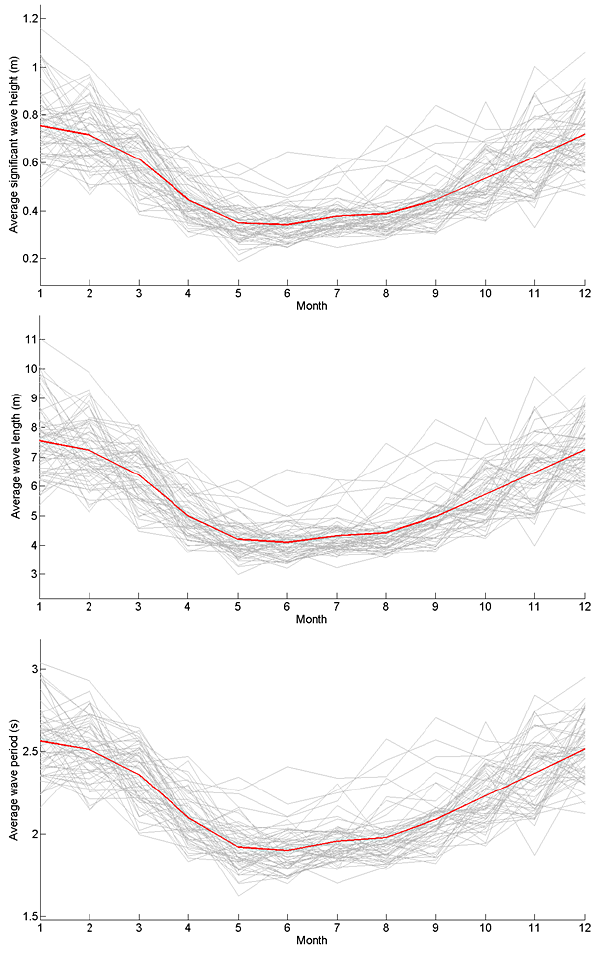
Figure 9. Monthly average values of significant wave height, wave length and period. Grey lines correspond to individual years, red lines show average values corresponding to the entire hindcast pe- riod.